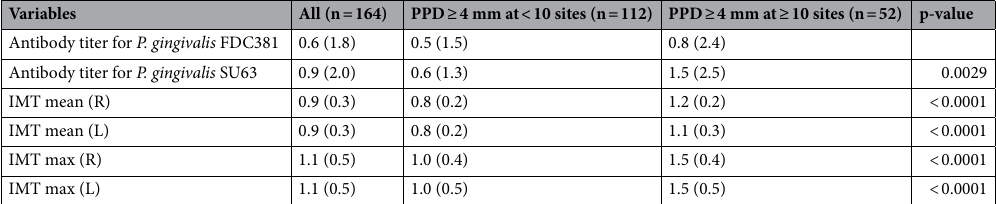
Table 3. Baseline characteristics of the study population. ALP alkaline phosphatase, ALT alanine aminotransferase, AST aspartate aminotransferase, BMI body mass index, BOP bleeding on probing, CAP controlled attenuation parameter, CAL clinical attachment level, DPP4 dipeptidyl peptidase-4, EAA endotoxin activity assay, GGT gamma-glutamyl transferase, HDL-C high-density lipoprotein cholesterol, HOMA-R homeostasis model assessment-estimated insulin resistance, hsCRP high-sensitivity C-reactive protein, IMT (R: right, L: left) intima-media thickness (R, L), LDL-C low-density lipoprotein cholesterol, LSM liver stiffness measurement, MRE magnetic resonance elastography, MRI magnetic resonance imaging, PDFF proton density fat fraction, PPD periodontal pocket depth, T.Bil total bilirubin, Tcho total cholesterol, TG triglycerides, VCTE vibration-controlled transient elastography. a Data are reported as means (SDs) or numbers (percentages). The